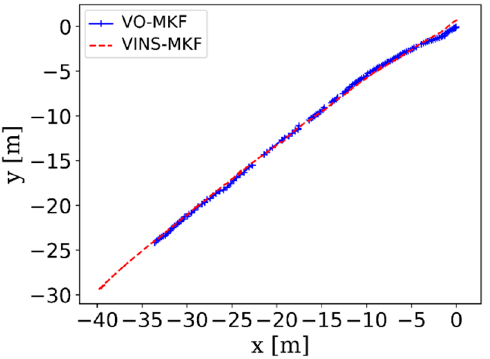
Figure 18. The trajectories of VINS-MKF (Red) and VO-MKF (Blue) in corridor environment.